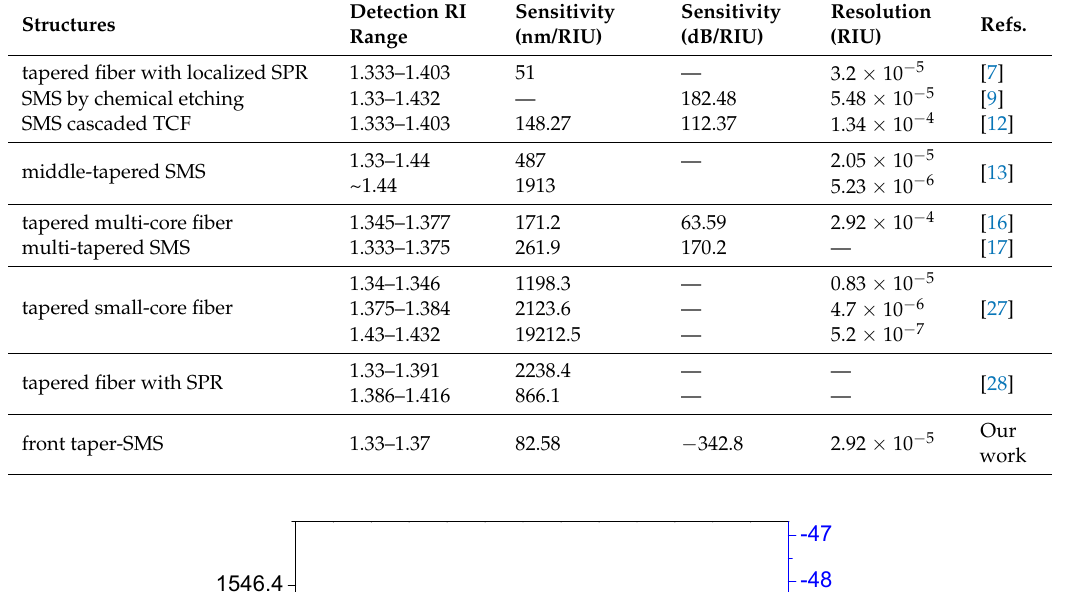
Table 1. Comparisons of sensitivity and resolution.